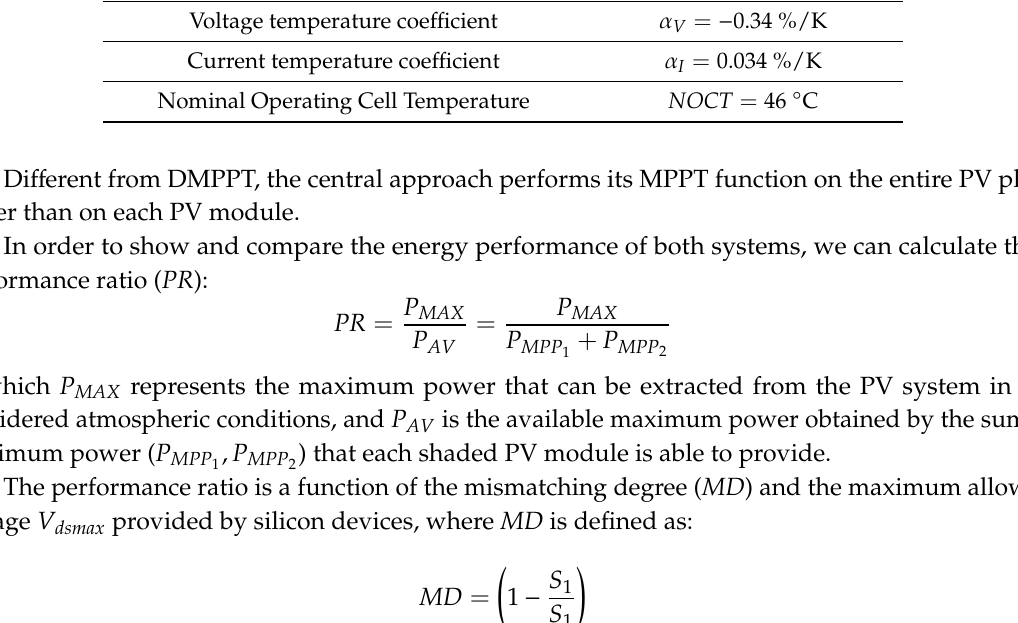
Table 1. SolarWorld SW 225 PV module electrical characteristics in standard test conditions (STC).